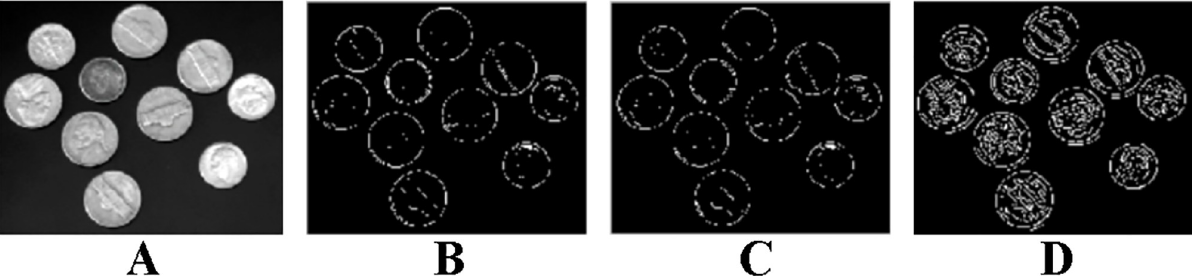
Fig 3. Results of different edge detectors (A is the original image; B is the Sobel detector; C is the Prewitt detector; D is Canny detector).